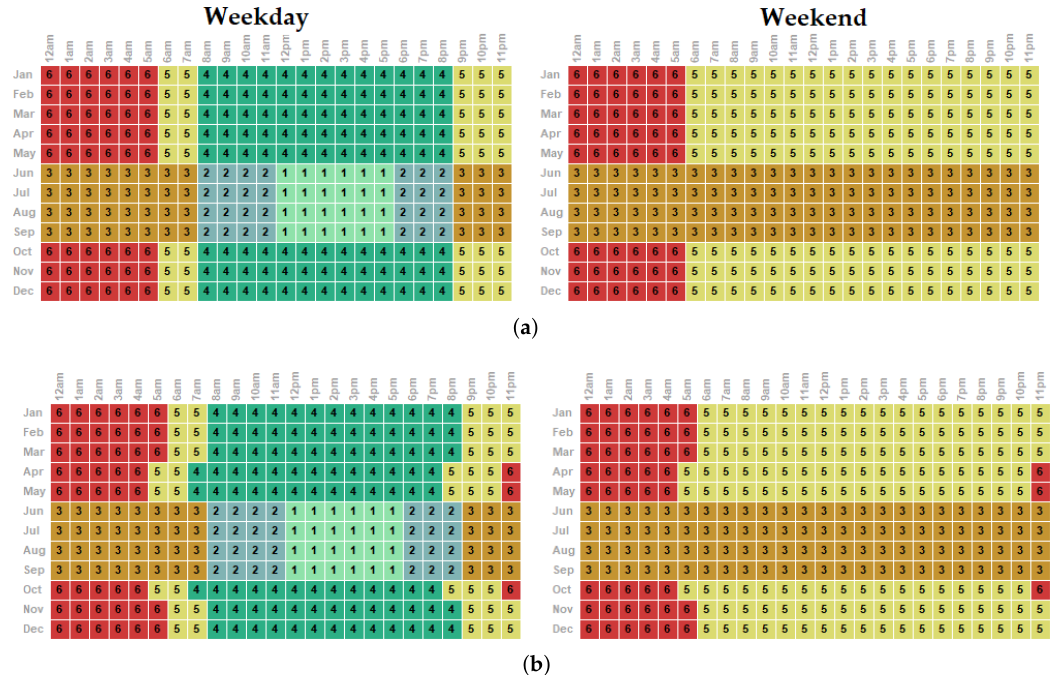
Figure 6. Different Time-of-Delivery factors used to assess the Levelised Cost of Electricity. ( a ) SAM’s default Time-of-Delivery factors. ( b ) Delivery factors of the SunShot Vision Study case